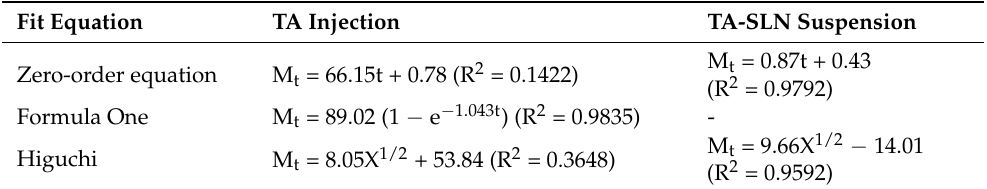
Table 4. Fitting equations of the cumulative release of TA versus time from the TA-SLN suspension and TA injection.